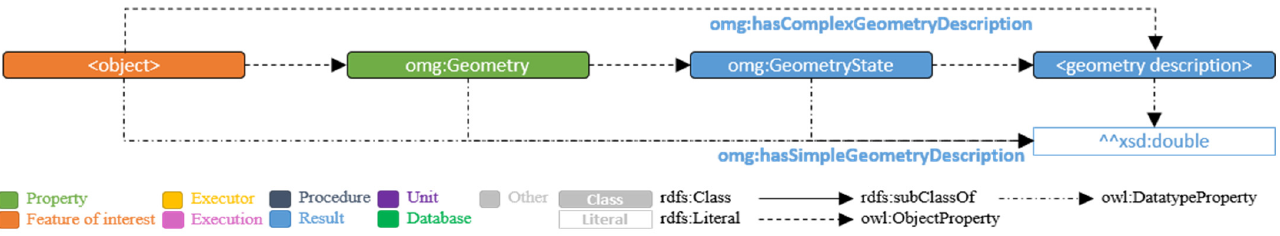
Figure 4. Four levels of detail to describe properties in OMG.